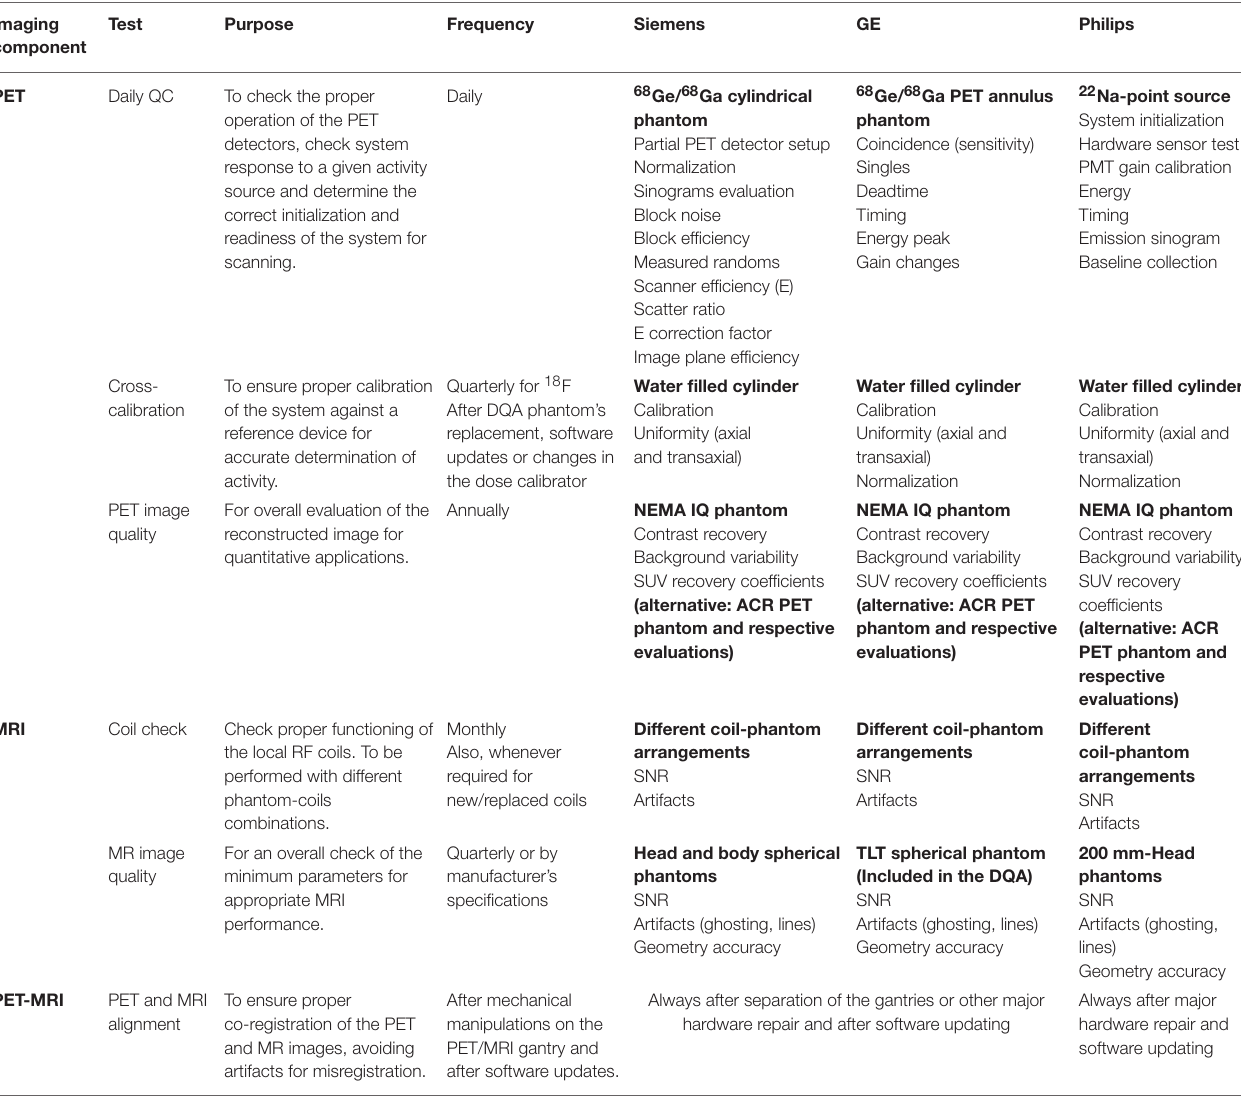
TABLE 7 | HYBRID consensus recommendations on quality control tests for PET/MRI systems. Imaging component